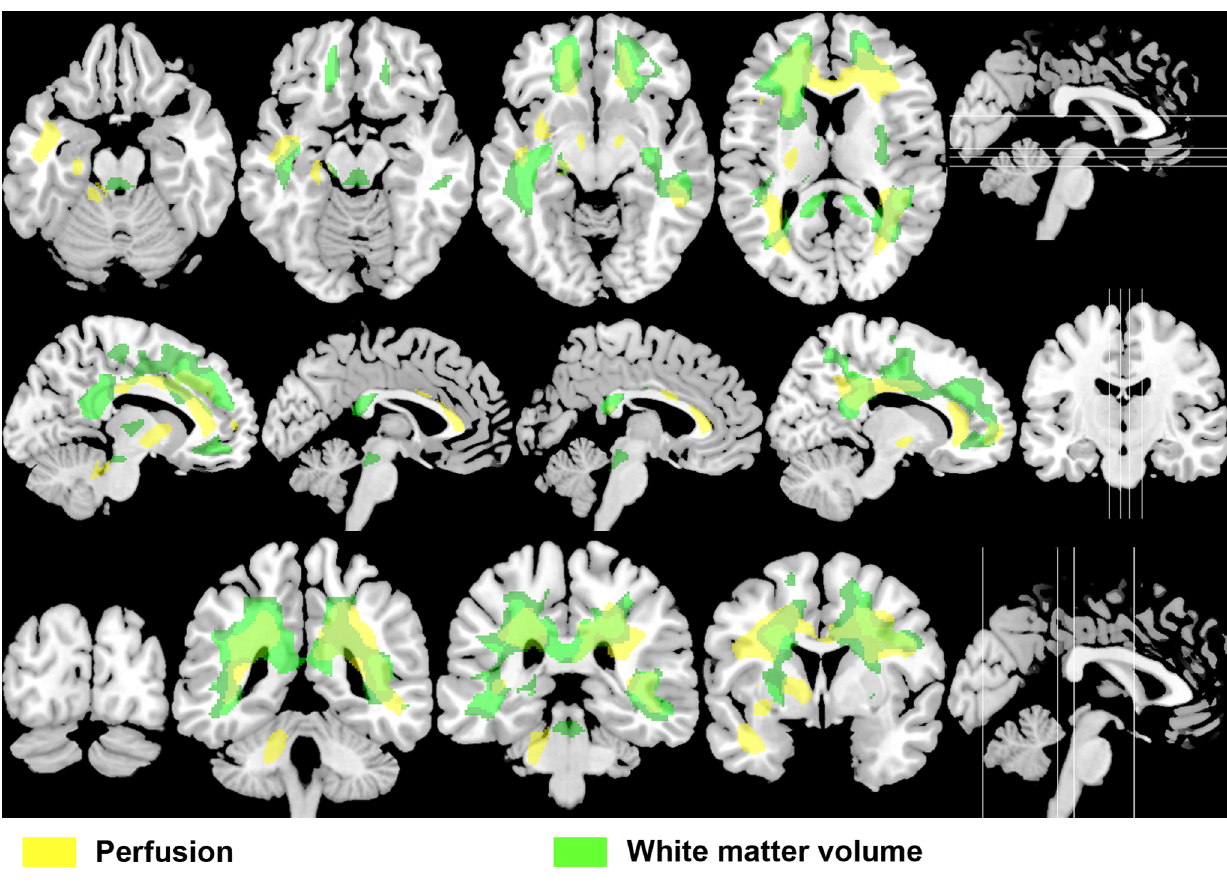
Table 5. Brain regions with positive correlation between perfusion and the number of optic neuritis attacks.